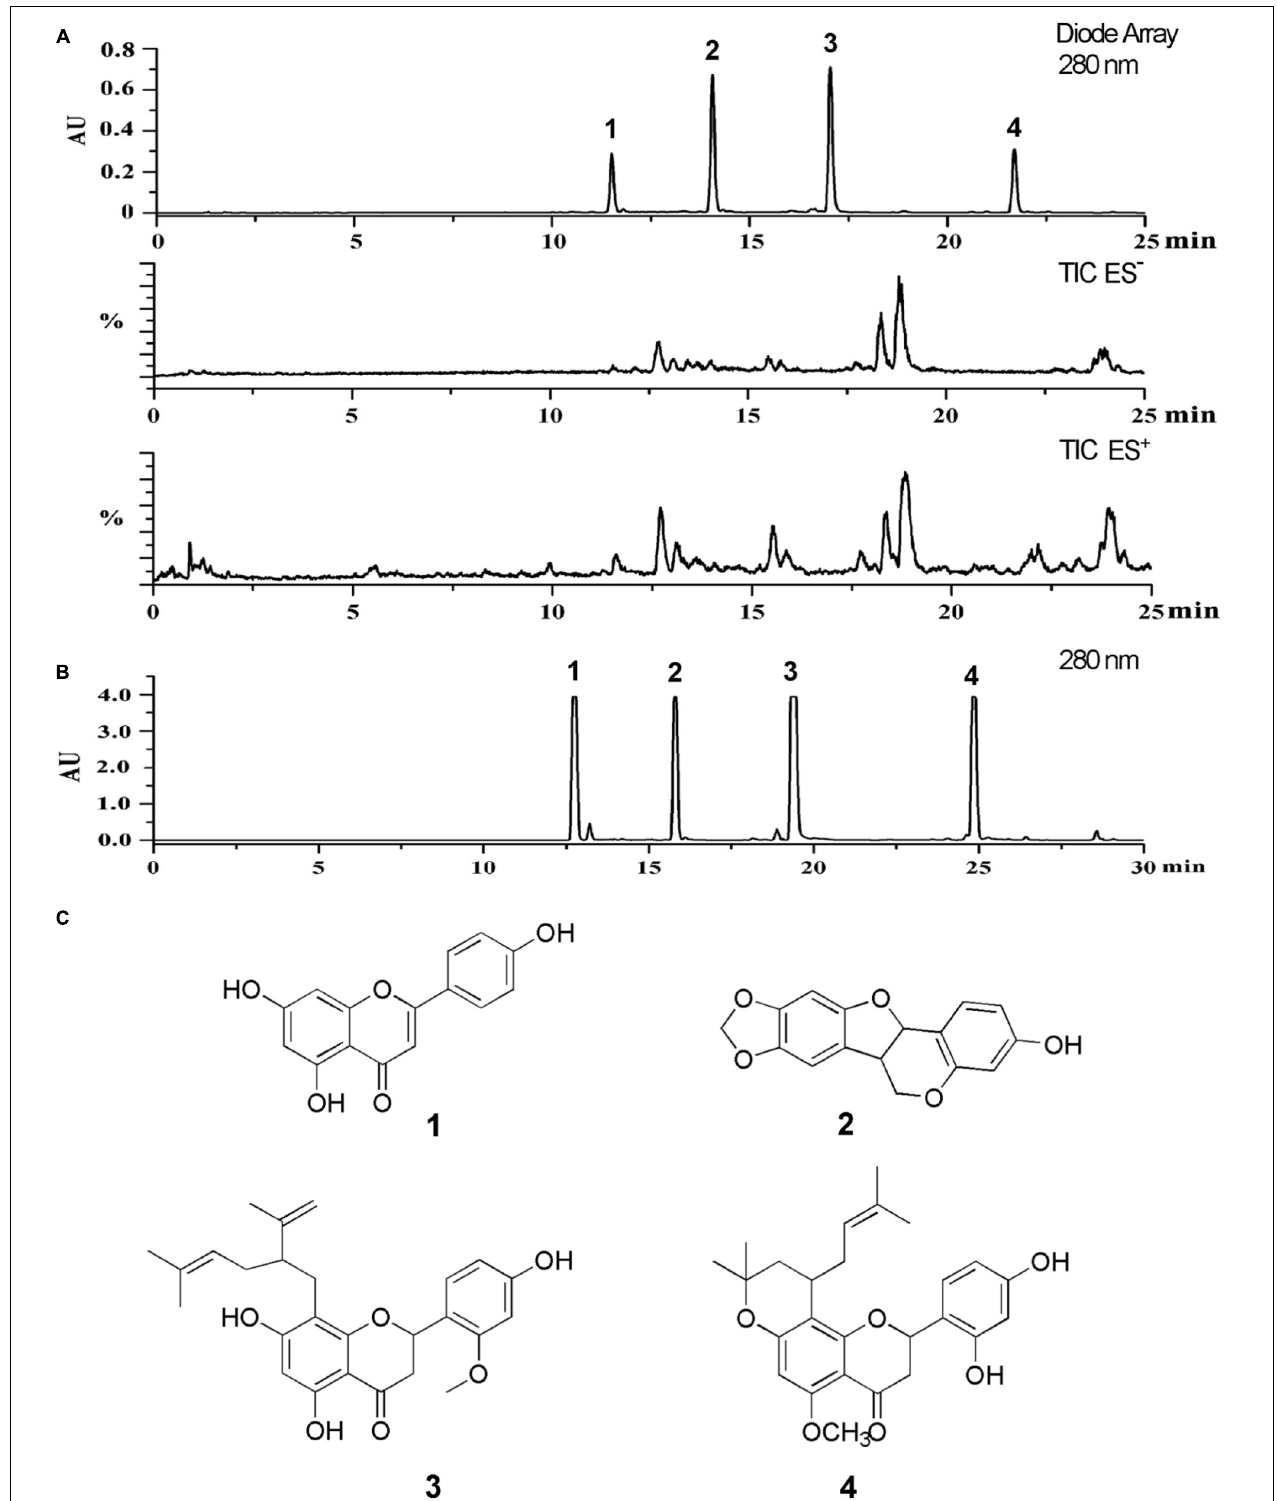
FIGURE 1 | (A) The LC-PDA-ESIMS analysis of SD-FRE is shown at 280 nm with peak labeling corresponding to compounds 1–4. (B) The optimized semi-preparative HPLC separation of the SD-FRE (10 mg in 200 µ L DMSO) is shown at 280 nm with peaks 1–4 collected for microprobe NMR and further purified if required. (C) Structures of 4 flavonoids from